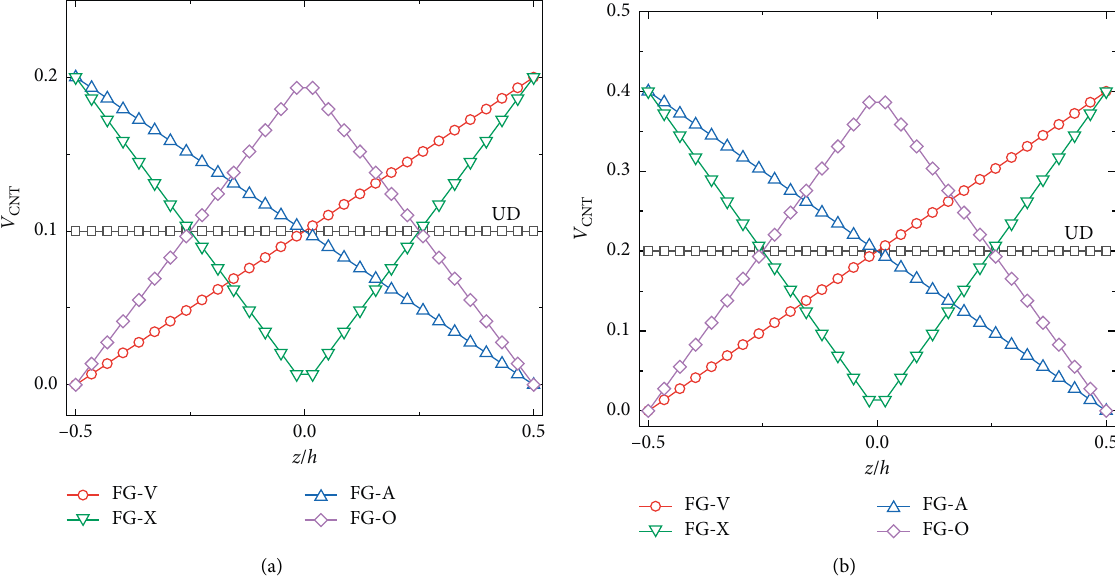
� 0 . 1. (b) V ∗ � 0 . CNT CNT